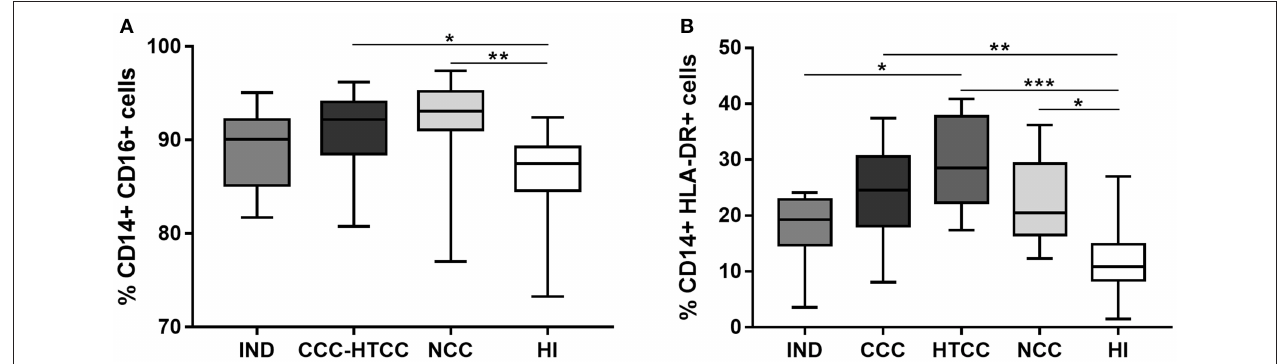
FIGURE 1 | Analysis of CD14 + CD16 + (A) and CD14 + HLA-DR + (B) cells percentages from peripheral blood of chagasic patients classified as IND, CCC, and HTCC, and controls defined as NCC and HI. Multiple comparisons were done with the Kruskal-Wallis test followed by Dunn’s post-hoc test. Differences are indicating